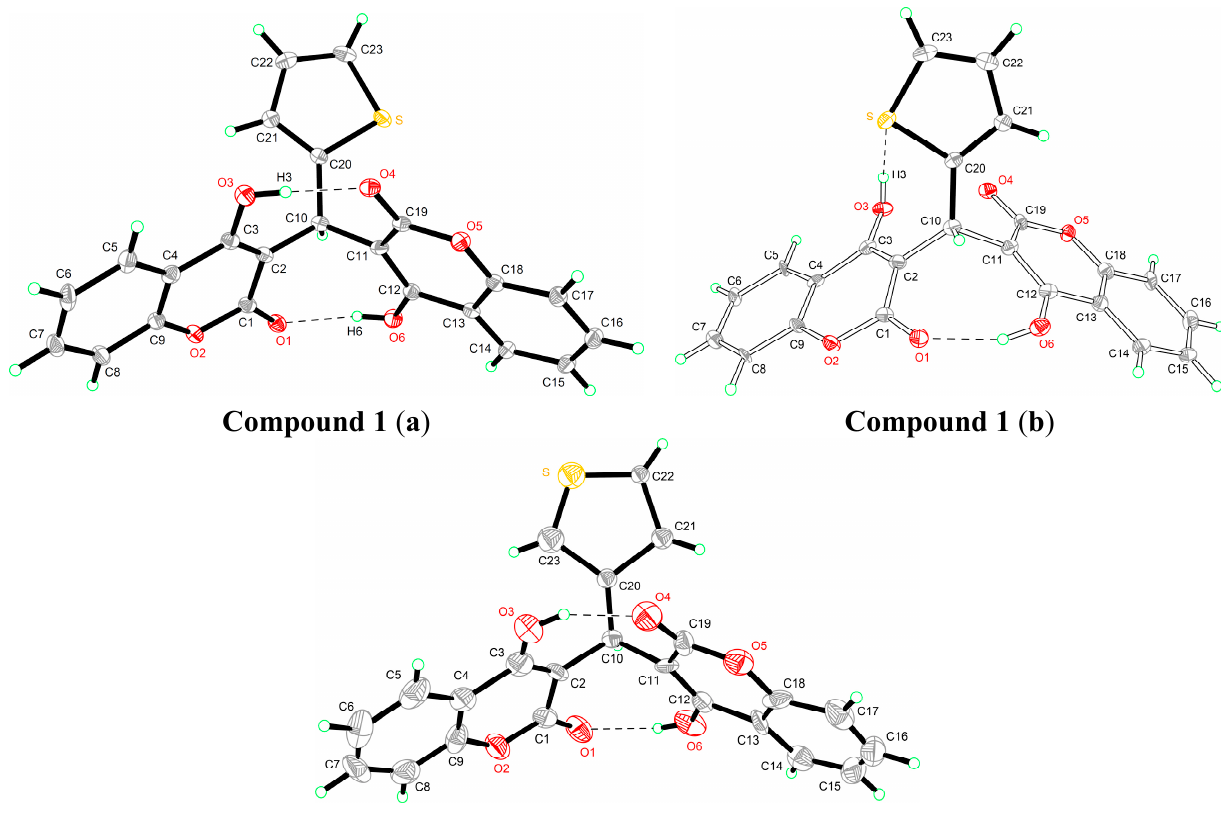
Figure 2. Crystal structures of compounds 1 and 5